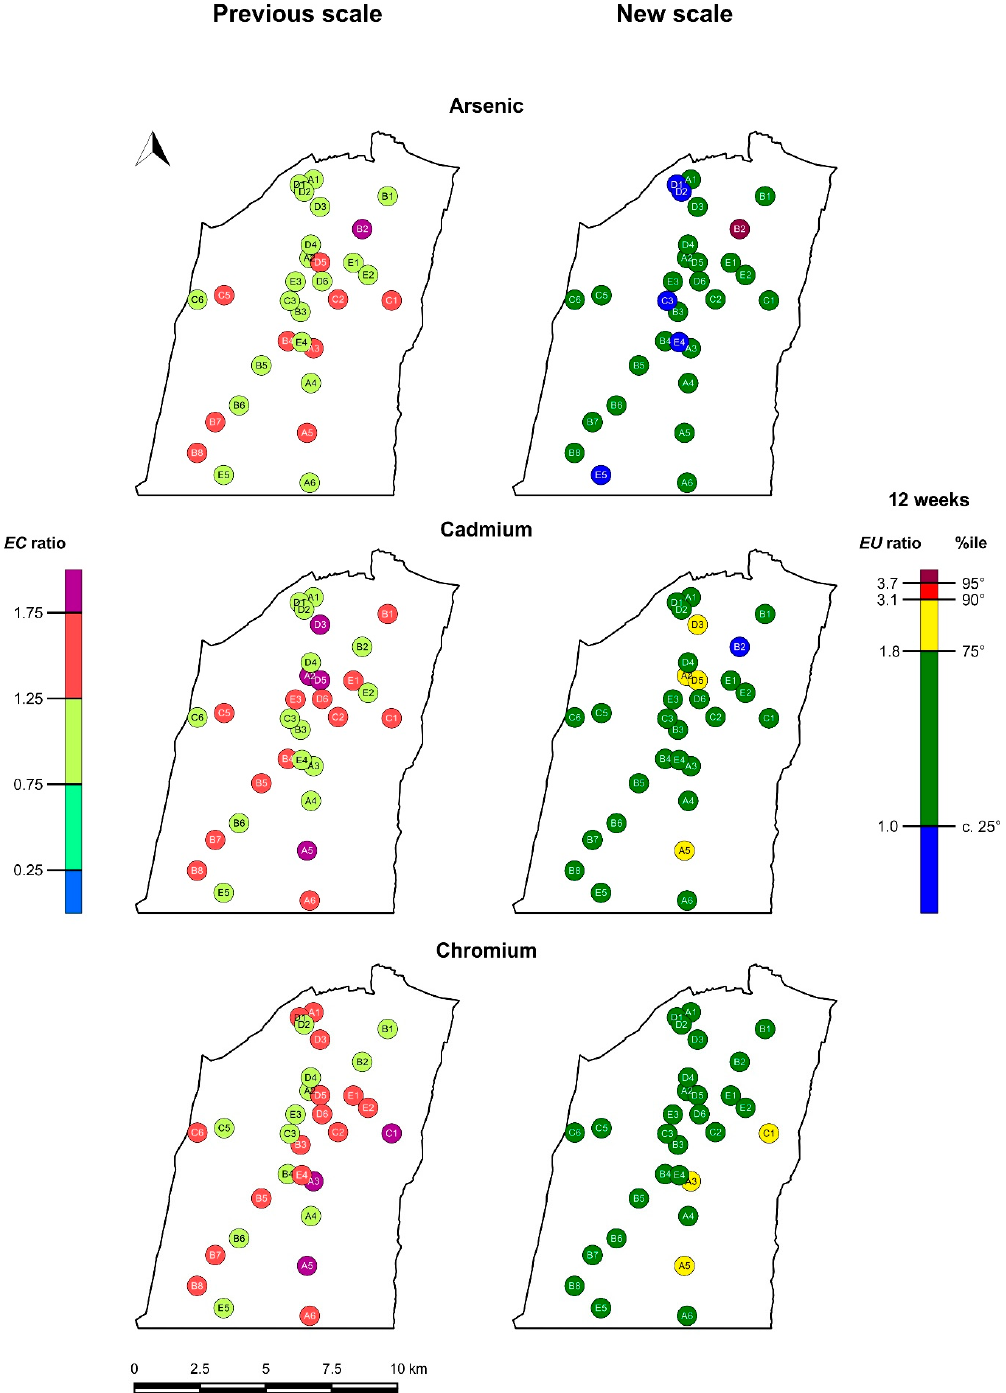
Figure 4. Cartographic representation of Pseudevernia furfuracea transplant sites, corresponding classes of the accumulation/loss scale [27] (here, “previous scale”) and the bioaccumulation scale (Table 5; here, “new scale”), with indication of EC ratios (Table 1) for the former, percentile thresholds (%ile), and EU ratios for the latter. Transplant sites are identified by alphanumeric codes (as also reported in Table S6).